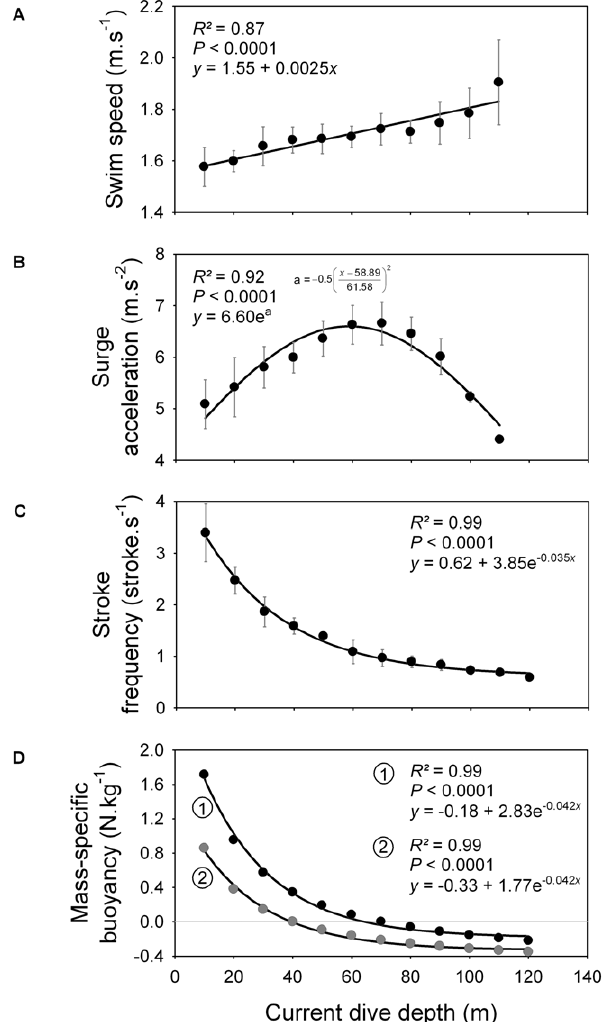
Figure 4. (A) Swim speed, (B) surge acceleration, (C) foot-stroke frequency and (D) mass-specific buoyancy, in relation to current dive depth, for the descent phase. For each current depth class, values of swim speed, surge acceleration and foot stroke frequency were calculated as the mean ( 6 S.D.) of the values calculated for different maximum dive depth categories (Fig. 2). For surge acceleration, the depth class near the end of the descent phase of each maximum dive depth category was excluded because acceleration suddenly decreases as the bird approaches the bottom. The deepest maximum dive depth category (120–130 m) was excluded from the regression (see Fig. 2). For calculation of mass-specific buoyancy, see Appendix S1. Grey circles and black circles correspond to the theoretical buoyancy of birds that load the volume of respiratory air necessary for attaining neutral buoyancy at 40 m and 70 m, respectively. Mass- specific buoyancy at the sea surface is 3.99 N.kg 2 1 and 2.28 N.kg 2 1 for relationship 1 and 2,